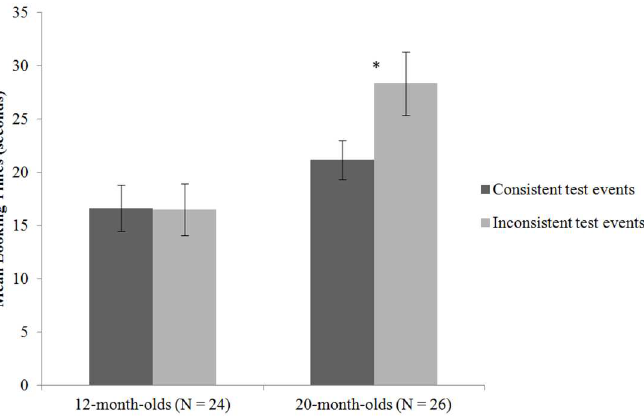
Fig 1. Infants’ mean looking times in the sensitivity to emotion in music